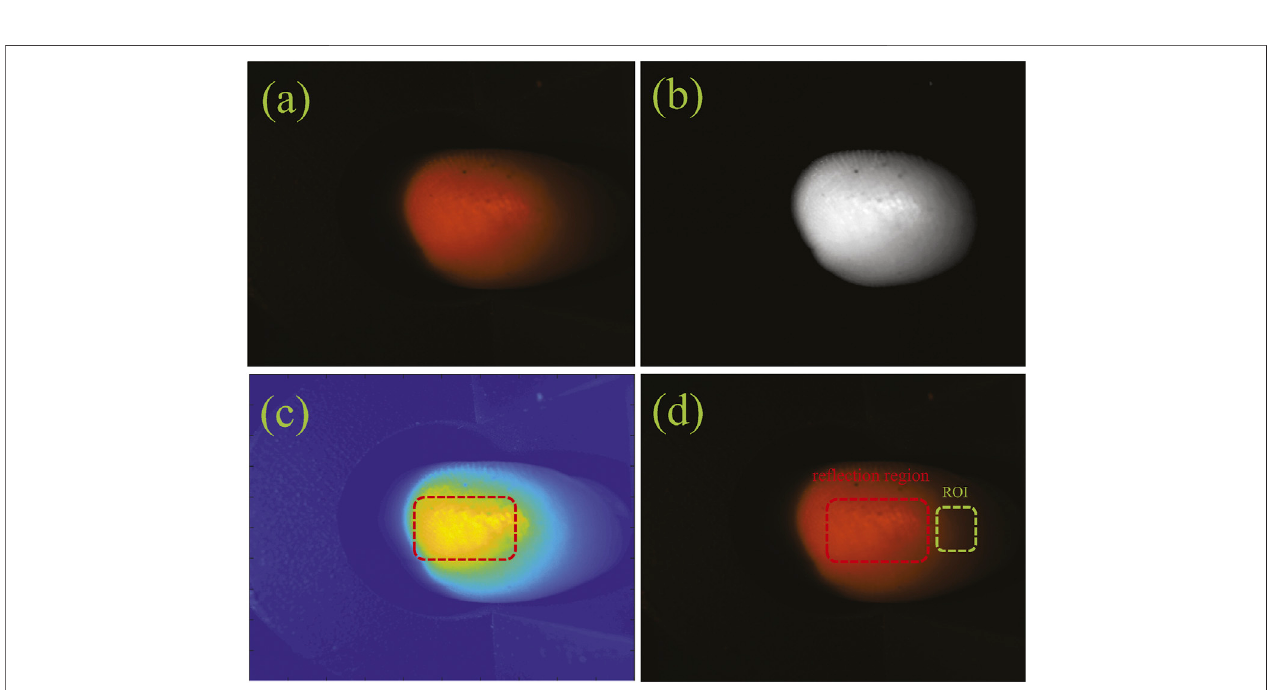
FIGURE 4 | The ROI of a diffuse image: (A) the original diffuse image; (B) the gray image; (C) the re fl ection image; (D) the ROI